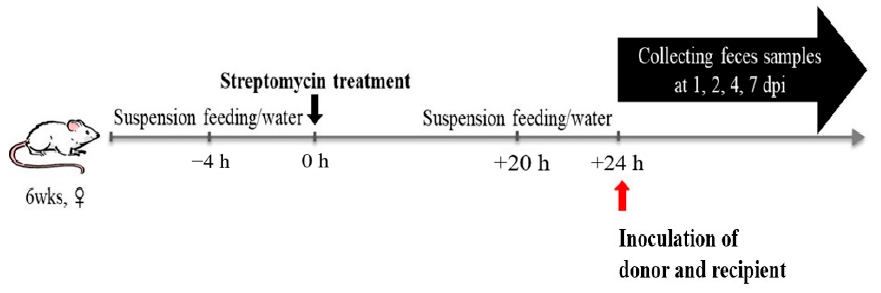
Figure 1. Schematic representation of in vivo transfer experiment set